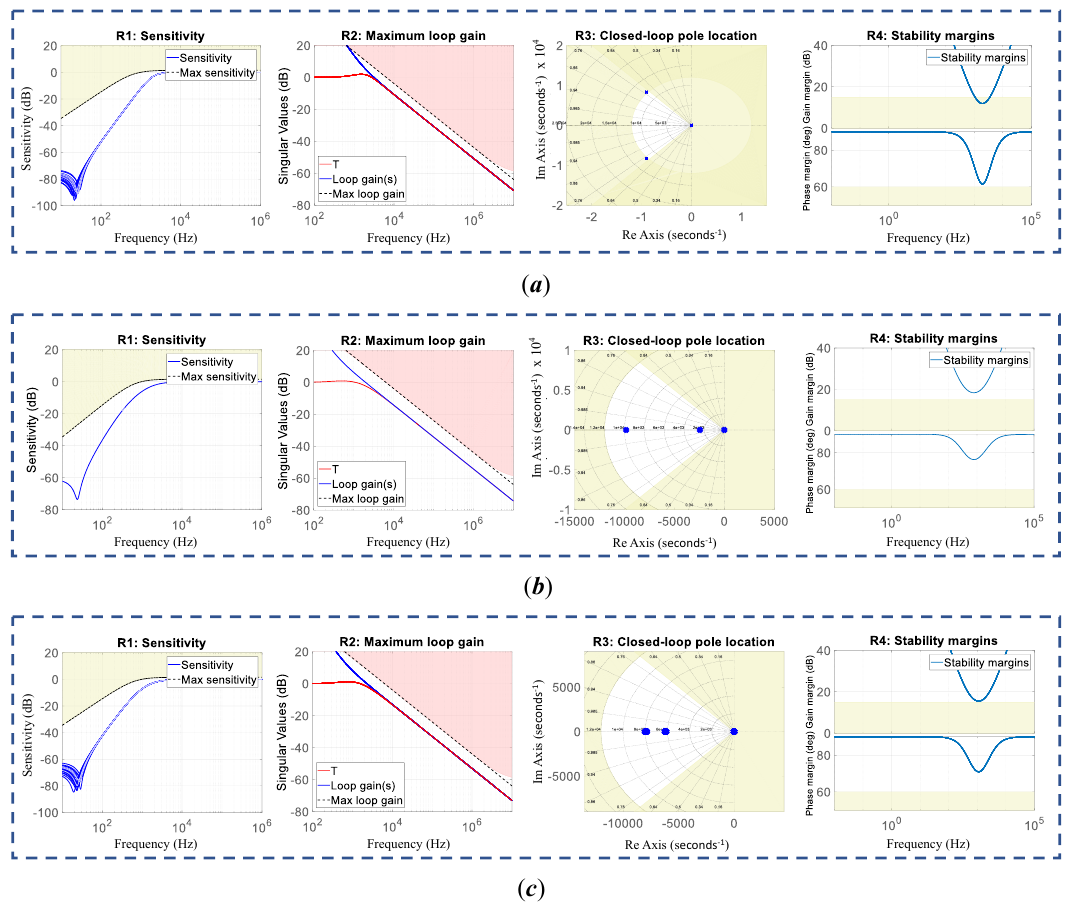
Figure 9. Closed-loop specifications’ verification for the i 0